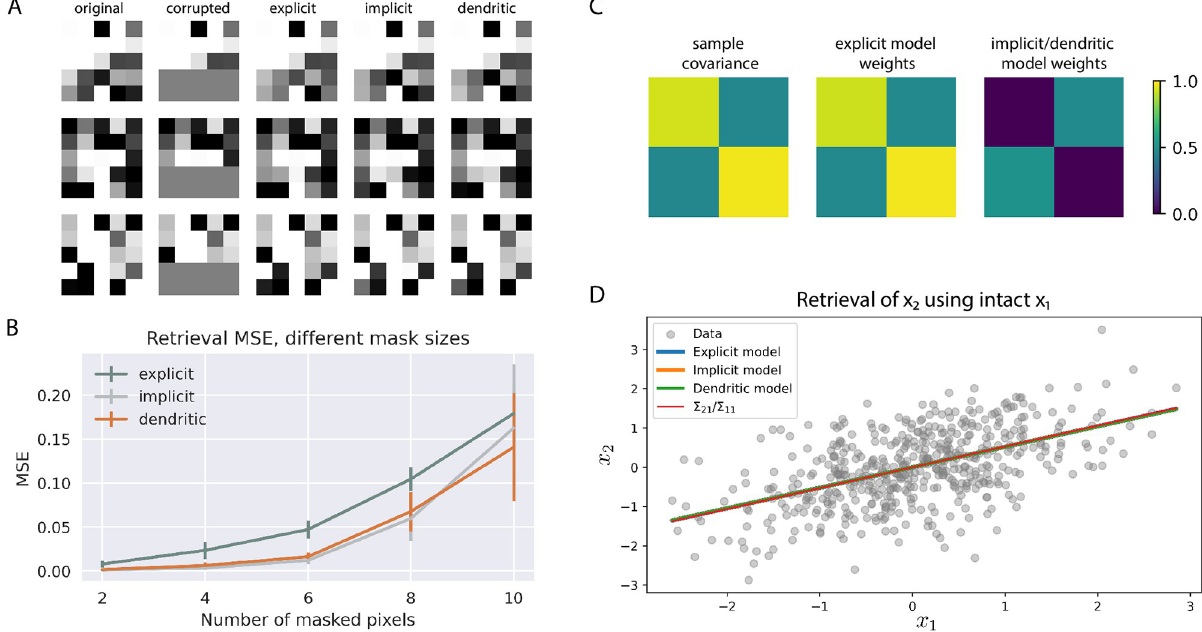
Fig 3. Performance of covPCNs in AM of random patterns, and the equivalence between them. A: A subset of 5 × 5 random patterns memorized by all 3 models. After training, we corrupted the bottom 2 rows (10 pixels) and let the networks run inference on the corrupted parts for retrieval. B: Retrieval MSEs of the models when corrupted with different mask sizes. Experiments in A and B are performed with networks with d = 25 neurons. C: Sample covariance of a random 2-dimensional dataset and the learned weight matrices of an explicit model and an implicit/dendritic model on this dataset. D: The random 2-dimensional dataset to memorize, and the linear retrieval obtained by masking the second dimension x 2 by all 3 models, as well as the theoretical retrieval line. All the lines overlap as they are equivalent in theory. Experiments in C and D are performed with networks with d = 2